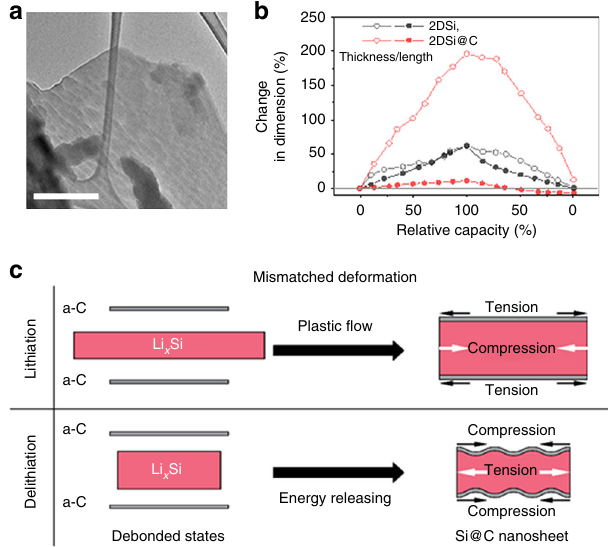
Fig. 3 Large deswelling ratio induced rippling in 2DSi@C. a An ex situ TEM image of 2DSi@C after the fi rst cycle. b The change in dimension versus SOC calculated from the chemomechanical modeling. c Illustrations of mechanical mismatch induced internal stress and rippling morphology in 2DSi@C during lithiation/delithiation process. Scale bar = 500 nm ( a )